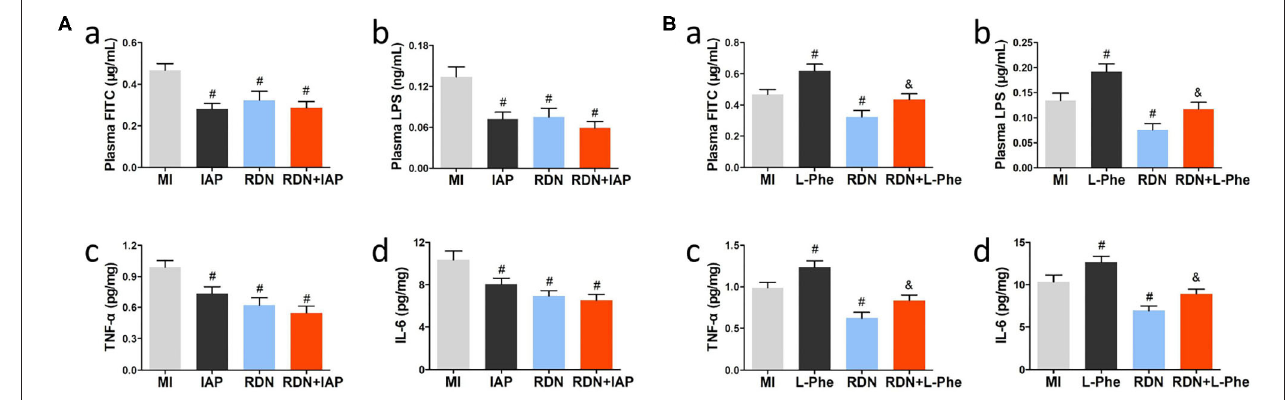
FIGURE 5 | The neuroprotection of RDN is associated with mitigating the MI-related intestinal injury in rats. (A) Treatment with IAP, like the RDN procedure, does not enhance the effects of RDN in attenuating intestinal permeability and neuroinflammation in the CNS of MI rats. (a) The plasma FITC-dextran concentrations in rats. (b) The plasma LPS levels in rats. (c,d) ELISA analysis of brain TNF- α and IL-6 in rats. (B) Treatment with L-phe mitigates the protective effect of RDN on preserving intestinal barrier integrity and reducing neuroinflammation in the CNS of MI rats. (a) The plasma FITC-dextran concentrations in rats. (b) The plasma LPS levels in rats. (c,d) ELISA analysis of brain TNF- α and IL-6 in rats. N = 8, 9, 7, 8, 8, and 7 for the MI, IAP, L-phe, RDN, RDN + IAP, and RDN + L-phe groups, respectively. # P < 0.05 vs. the MI group; & P < 0.05 vs. the RDN group. IAP, intestinal alkaline phosphatase; L-phe,